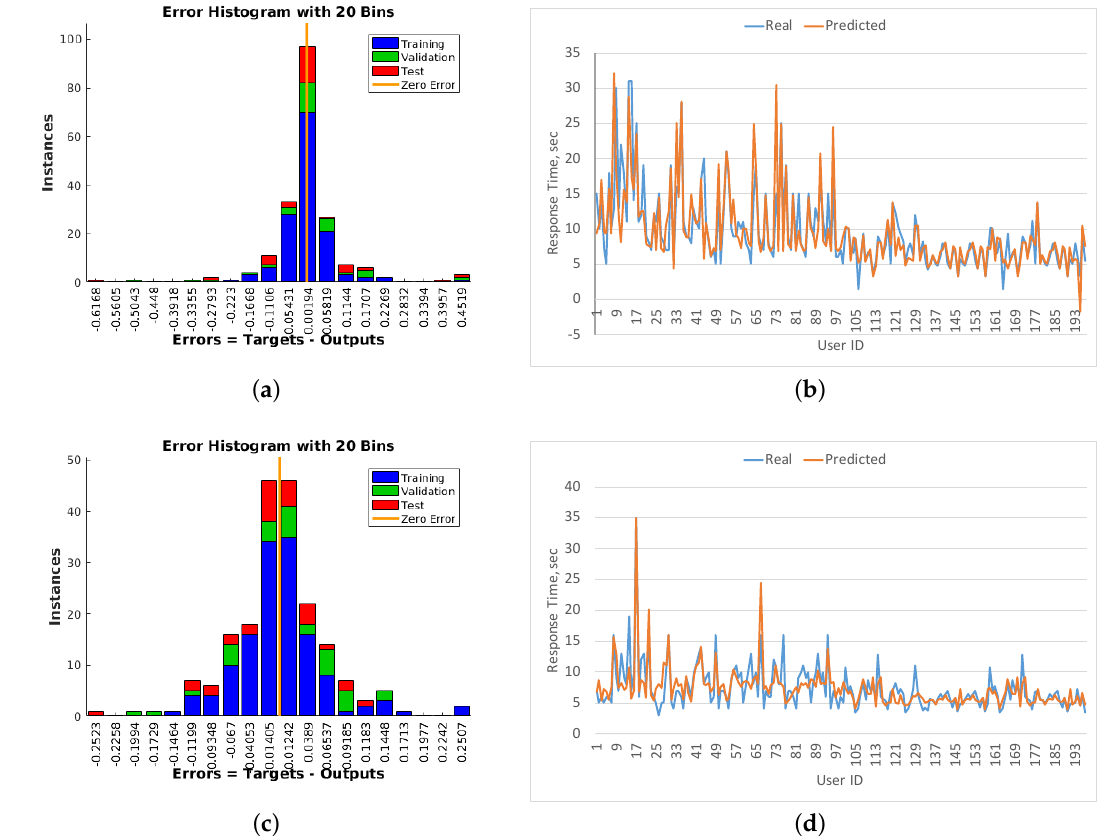
Figure 9. ( a ) Histogram of the error (target—predicted solution time) for one training, validation, and test part of the Dice 1 dataset ( N h = 45); ( b ) trend of the target vs. predicted solution times for the Dice 1 dataset; ( c ) histogram of the error (target—predicted solution time) for one training, validation, and test part of the Dice 2 dataset ( N h = 20); and ( d ) trend of the target vs. predicted solution times for the Dice 2